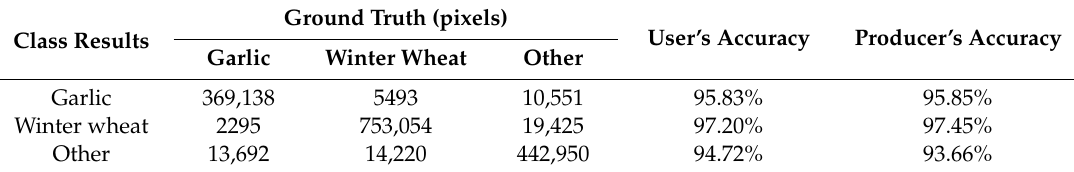
Table 3. Results of accuracy validation for the final garlic and winter wheat map